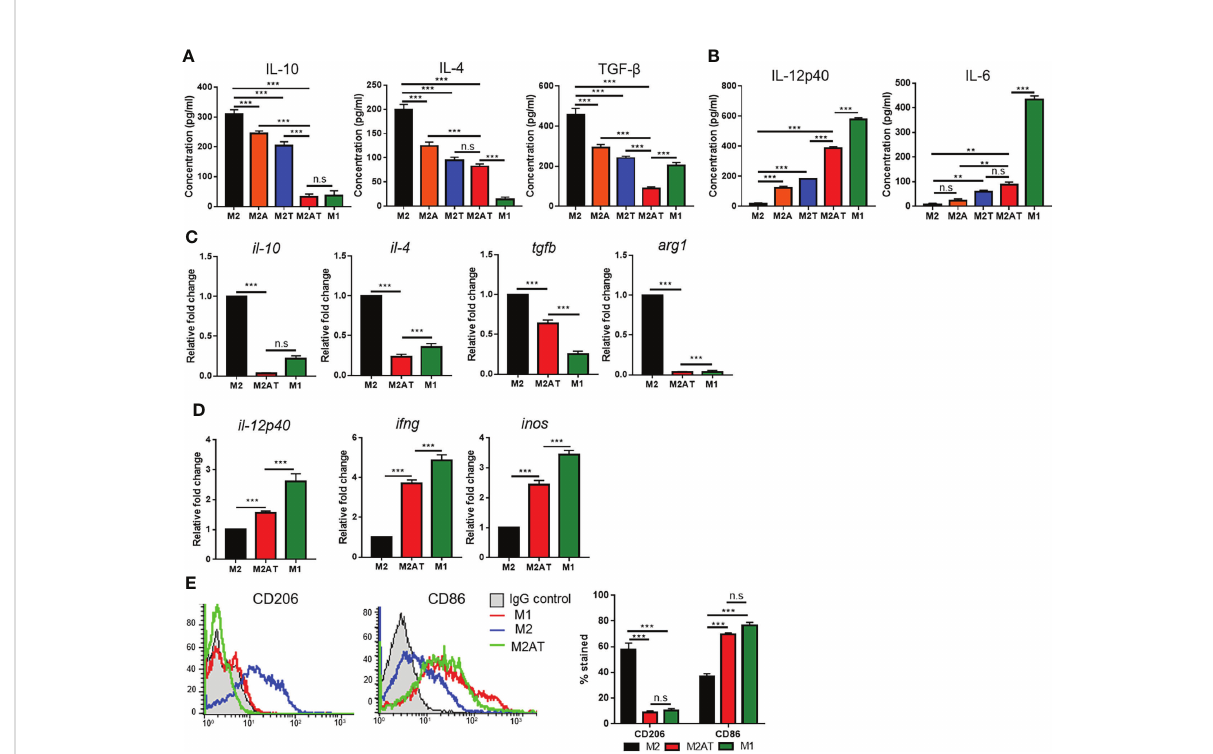
FIGURE 1 Epigenetic therapy with the combination of 5-aza-dC and TSA reprograms the M2-type macrophages towards an M1-like phenotype. (A, B) ELISA to quantify the M2-type (A) and M1-type (B) cytokines secreted into the culture medium after treatment of M2-type macrophages (M2) with 50 nM 5-aza-dC (M2A) and 25 nM TSA (M2T), alone or in combination (M2AT). M1-type macrophages (M1) were used as a control. (C, D) qRT-PCR analysis of the mRNA levels of M2-type (C) and M1-type (D) cytokines and markers after treatment of M2-type macrophages with 5- aza-dC and TSA in combination. (E) Flow cytometric analysis of the surface expression of CD206 and CD86 after treatment of M2-type macrophages with 5-aza-dC and TSA in combination. Data represent the mean ± SD of three separate experiments performed in triplicates. **, P <0.01; ***, P <0.001; n.s., not signi fi cant, as assessed using one-way ANOVA followed by Tukey ’ s multiple comparison post-hoc